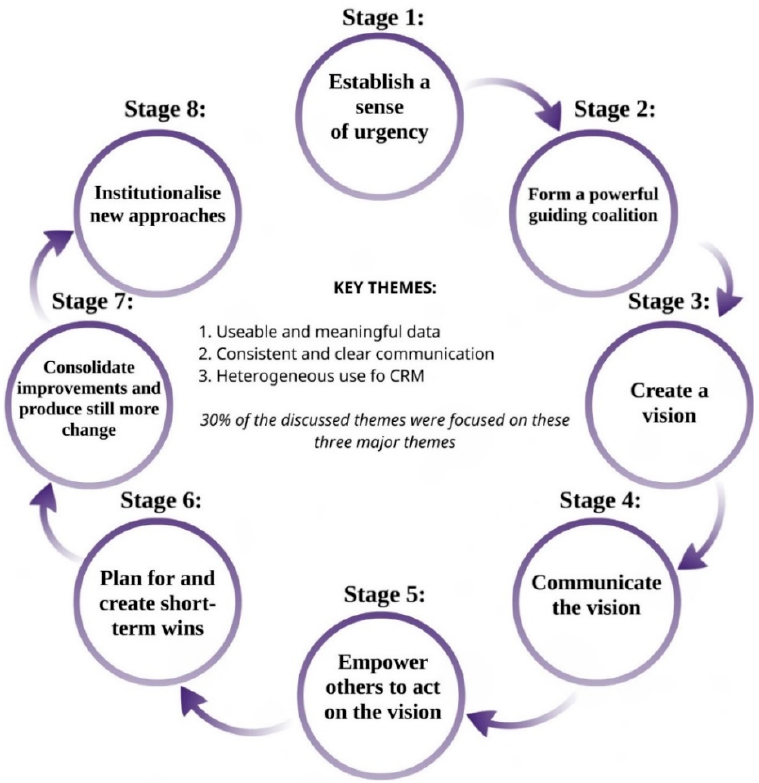
Figure 6. Three top major themes discussed in the interviews. Adapted from Kotter’s (1996) model.